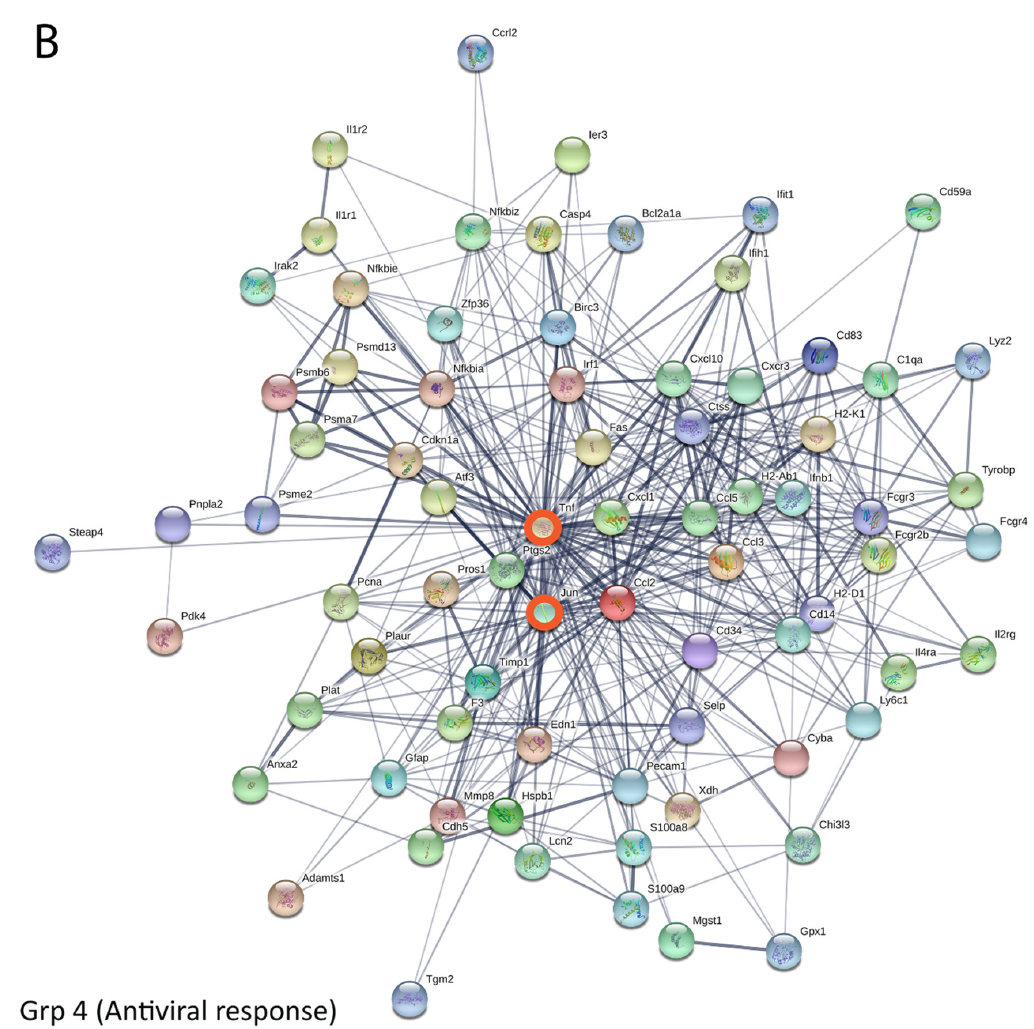
Figure 7. Network analysis of the up-regulated gene in Ifnar − / − mice reveals a TNF to be a crucial regulator for antiviral immune response. The figure depicts a modular network formed using the upregulated genes. ( A ) protein-to-protein interaction (PPI) network was developed using the STRING (Search Tool for the Retrieval of Interacting Gene) database. The interaction was divided into four groups using the K-means clustering tool from the STRING database. Each group defines the essential unique function: group 1 includes metabolic pathway genes, group 2 comprises olfactory related gene, group 3 represents the protein translation gene, and group 4 contains antiviral response-related genes. ( B ) Later, group 4 genes representing the antiviral response were used for the interactome generation by using the STRING database. The network shows the maximum connectivity patterns where Jun was found to have the highest number of connective nodes, followed by that of TNF- α .